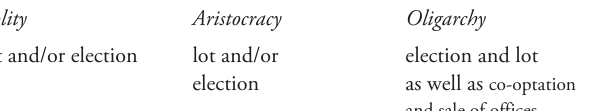
Table 2. Constitutional systems and appointment procedures in Aristotle’s “Th e